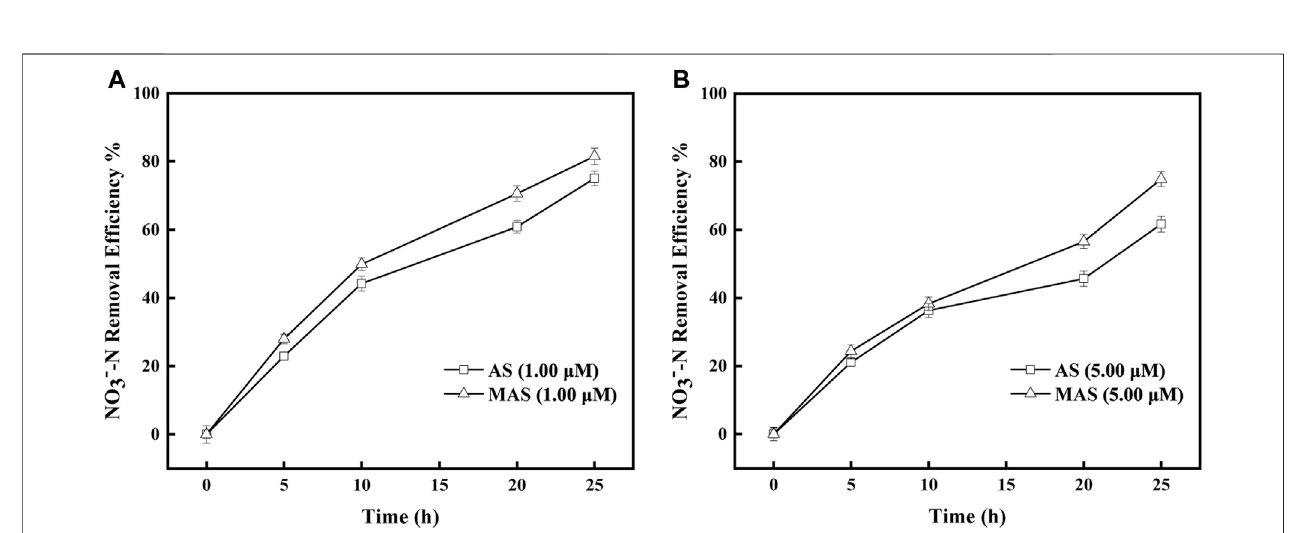
FIGURE 8 | Effect of nFe 3 O 4 on the QDH-inhibited respiratory chain in denitri fi cation. QDH concentrations were (A) 0.1 mM and (B) 0.25 mM, and NO 3 − -N was used as the fi nal electron acceptor.